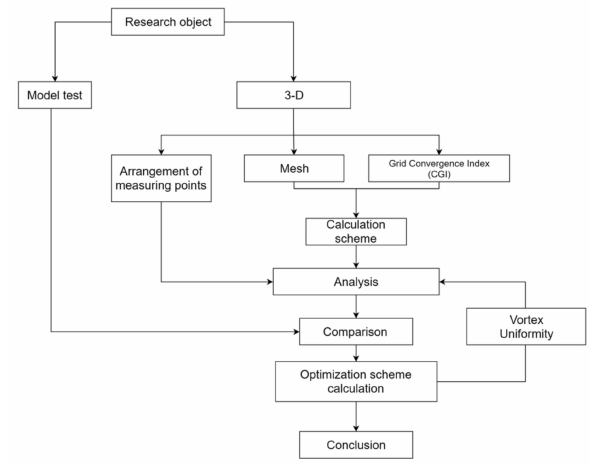
Figure 1. Analysis flowchart.